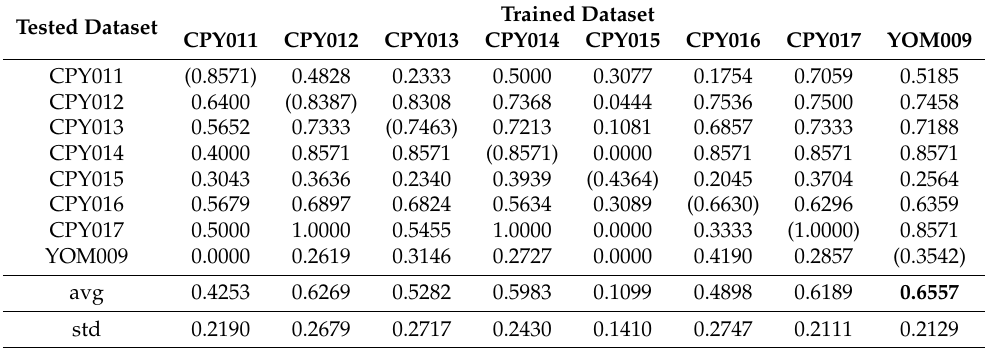
Table 8. The F1-scores of the LSTM models when testing with the dataset from the same station (shown in the bracket) and different stations.